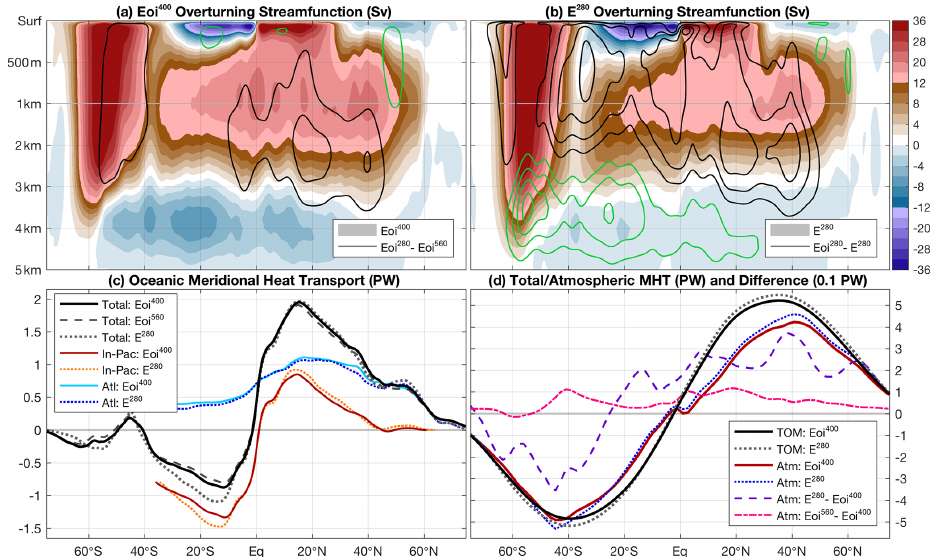
Figure 7. (a) Global oceanic meridional overturning stream function (MSF) of the Eoi 400 case (shading) and Eoi 280 − Eoi 560 difference (contours every 2Sv; black: positive; green: negative), taking the mean over the last 500 model years. Panel (b) is the same as (a) but for the E 280 case and the Eoi 280 − E 560 difference. Note the vertical stretching of the upper 1km. (c) Oceanic meridional heat transport in the Eoi 400 (solid lines; global: black; Indo-Pacific: red; Atlantic Ocean: blue), E 280 (dashed lines, similar colouring), and Eoi 560 (dotted line, only global). (d) Total meridional heat transport, induced by the top-of-model (TOM) net radiative fluxes (Eoi 400 : solid black; E 280 : dotted grey) and the corresponding atmospheric heat transport (Eoi 400 : solid red; E 280 : dotted blue). The difference in atmospheric heat transport with respect to the Eoi 400 is shown for the E 280 (dashed pink) and Eoi 560 (dash-dotted pink), both of which are magnified